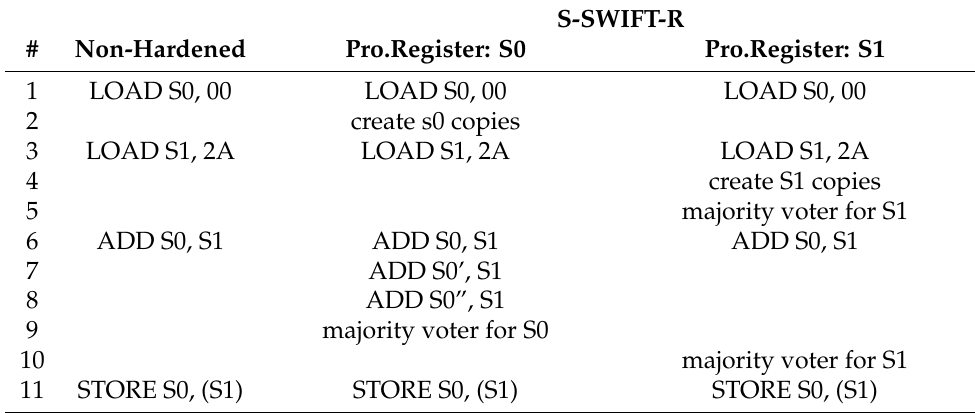
Table 2. The difference between non-hardened and